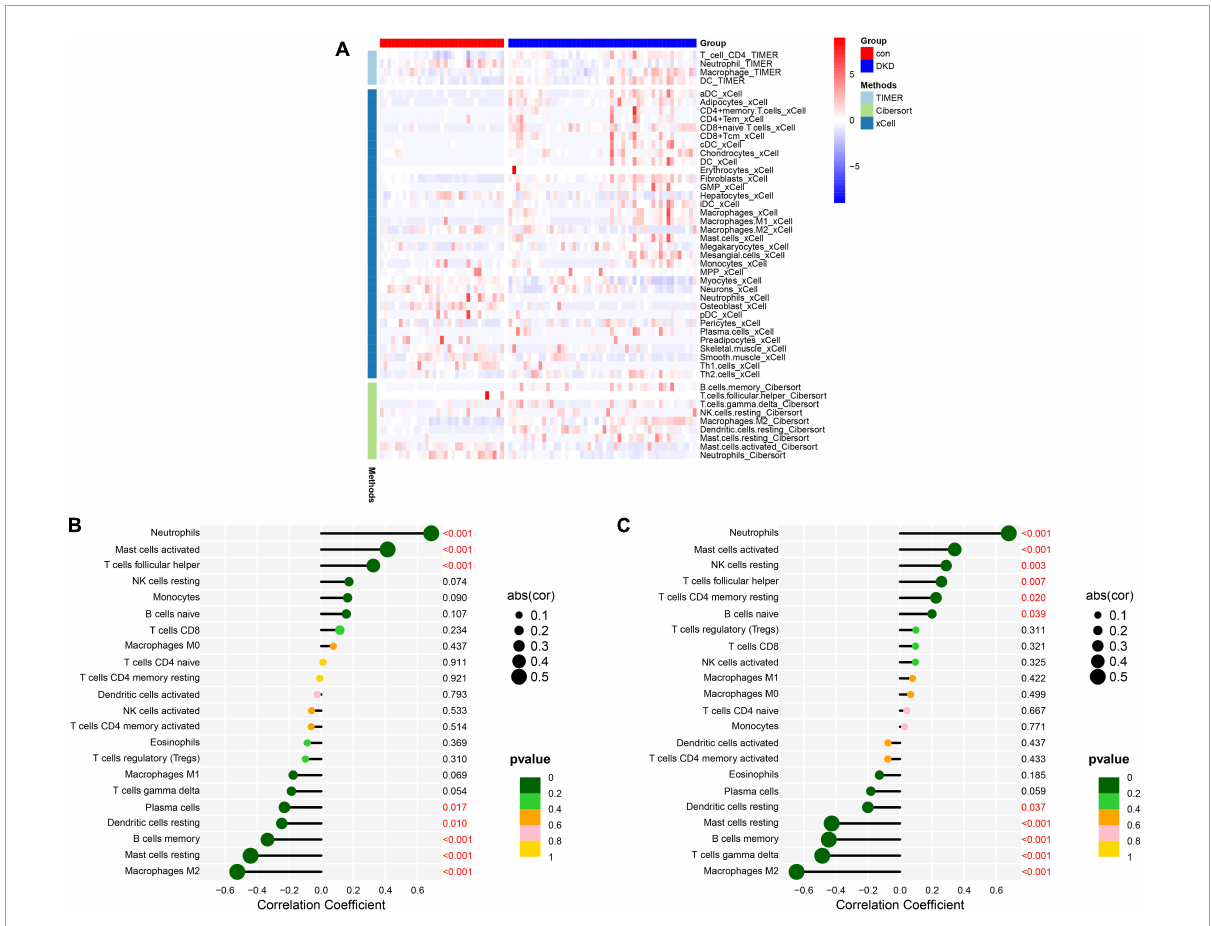
FIGURE8 Analysis of immune cell infiltration. (A) The heatmap of immune cells with differential infiltration between DKD patients and controls based on CIBERSORT, XCELL and TIMER algorithms. (B) Correlations between DUSP1 expression and the extent of infiltration of immune cell subtypes. (C) Correlations between PRKAR2B expression and the extent of infiltration with immune cell subtypes.